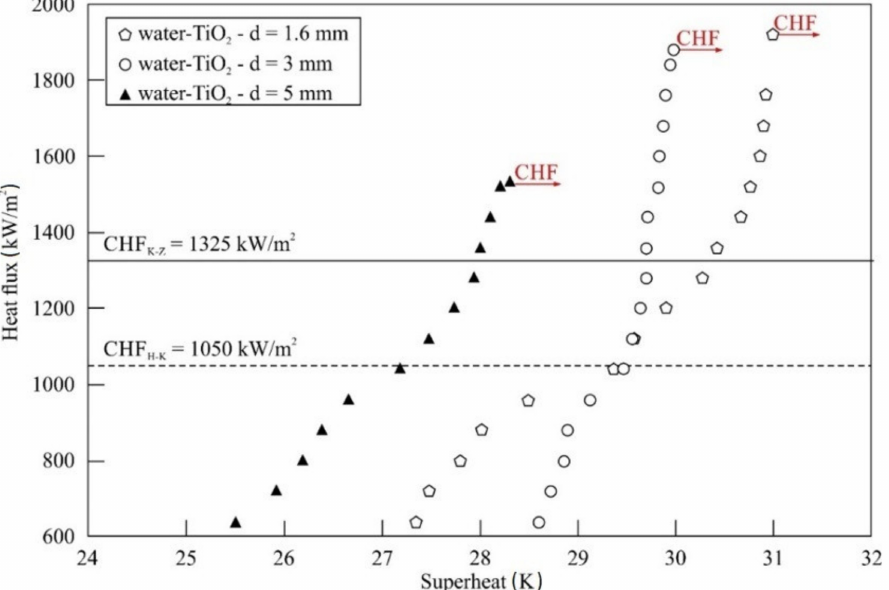
Figure 8. Boiling curves and CHF for water–TiO 2